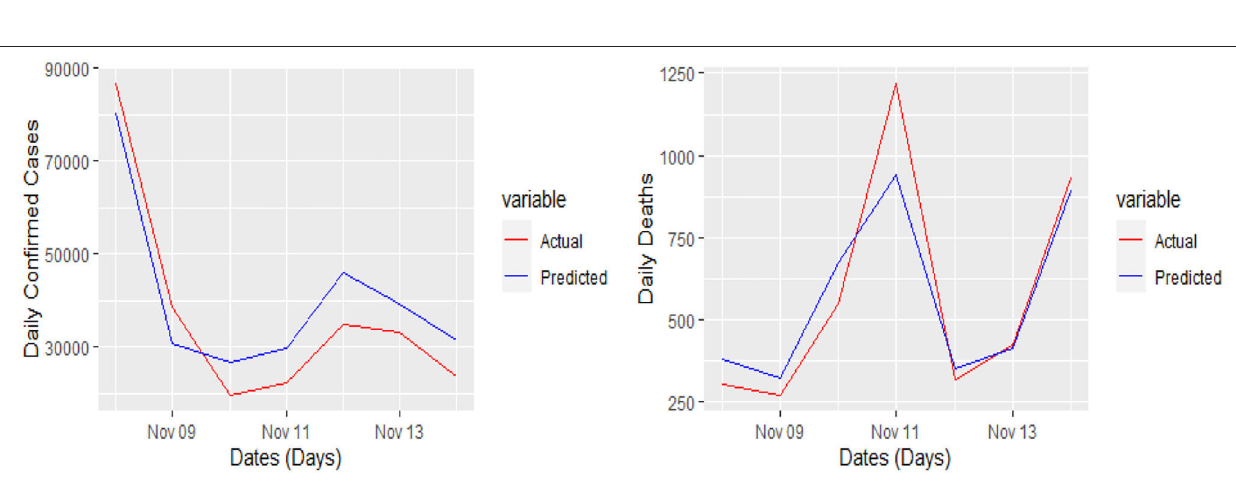
FIGURE 6 | Actual and predicted 7 days daily confirmed cases and daily deaths in France from COVID-19.